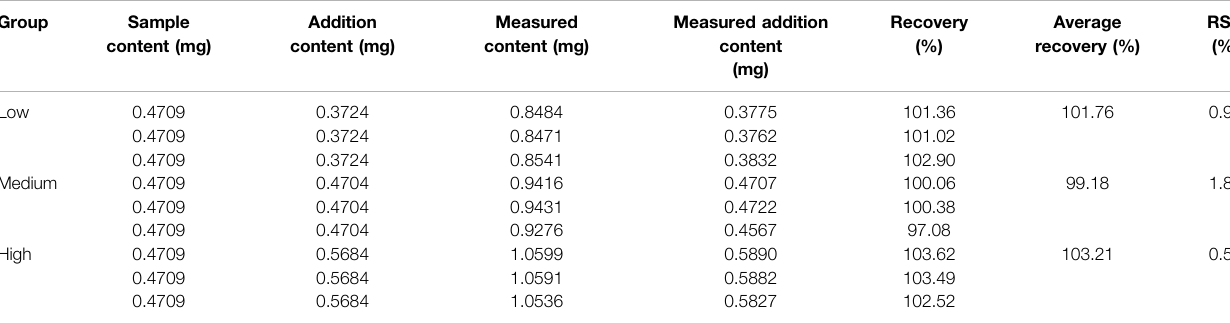
TABLE 5 | The recovery test results of Nuezhenoside G13.